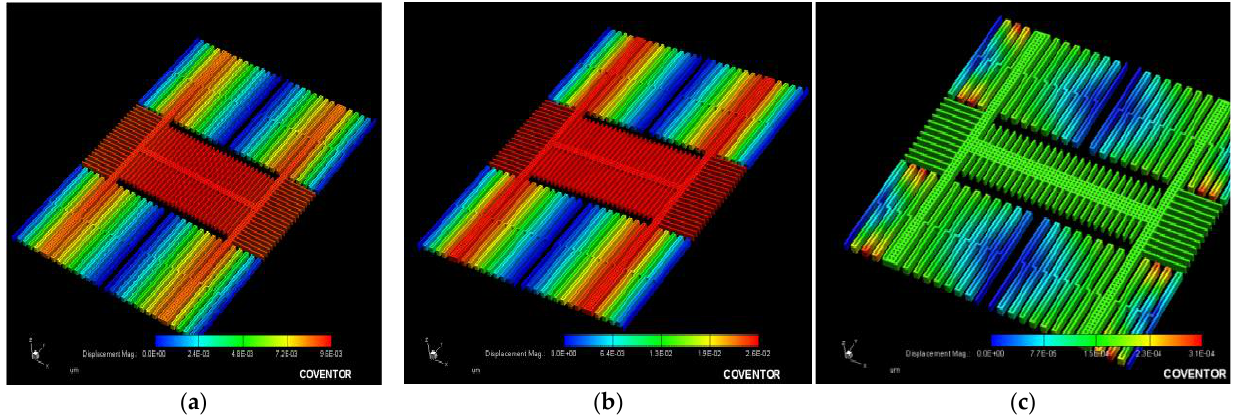
Figure 2. ( a ) Model of sensing x- and y-axis (in-plane) magnetic field; ( b ) model of sensing z-axis (out-plane) magnetic field.